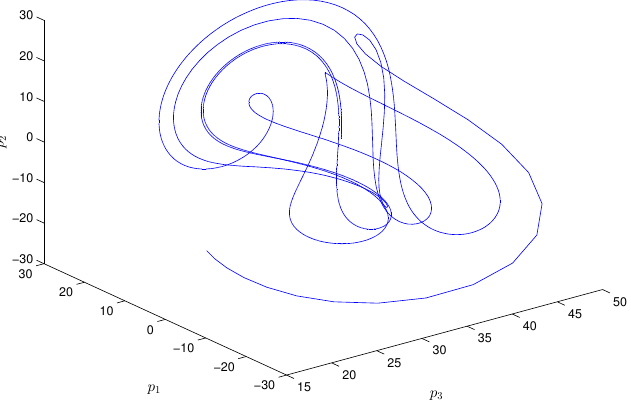
Figure 2. A 3D phase portrait of the non-autonomous Chen system (18).